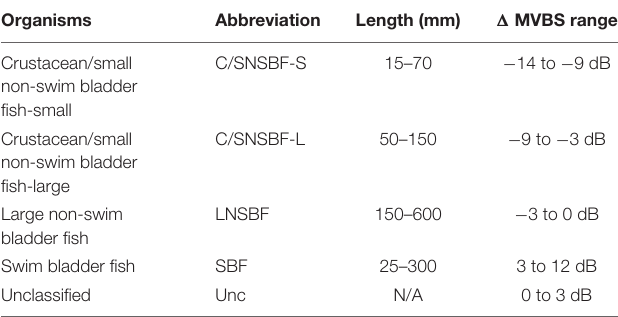
TABLE 1 | Category of acoustic